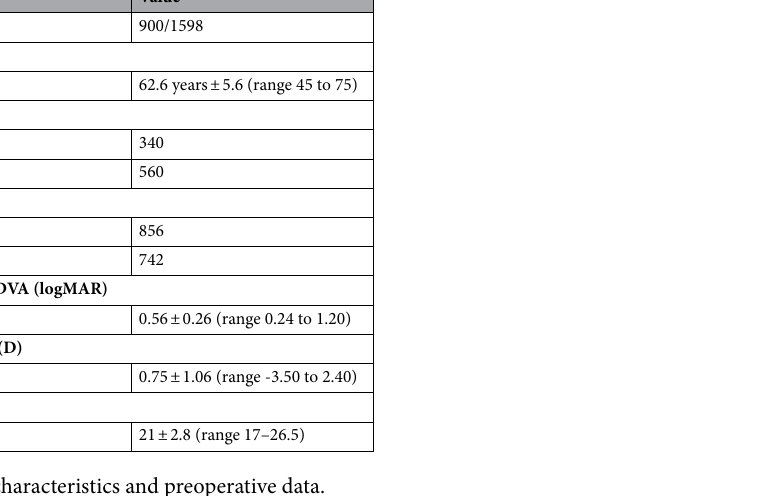
Table 1. Patient characteristics and preoperative